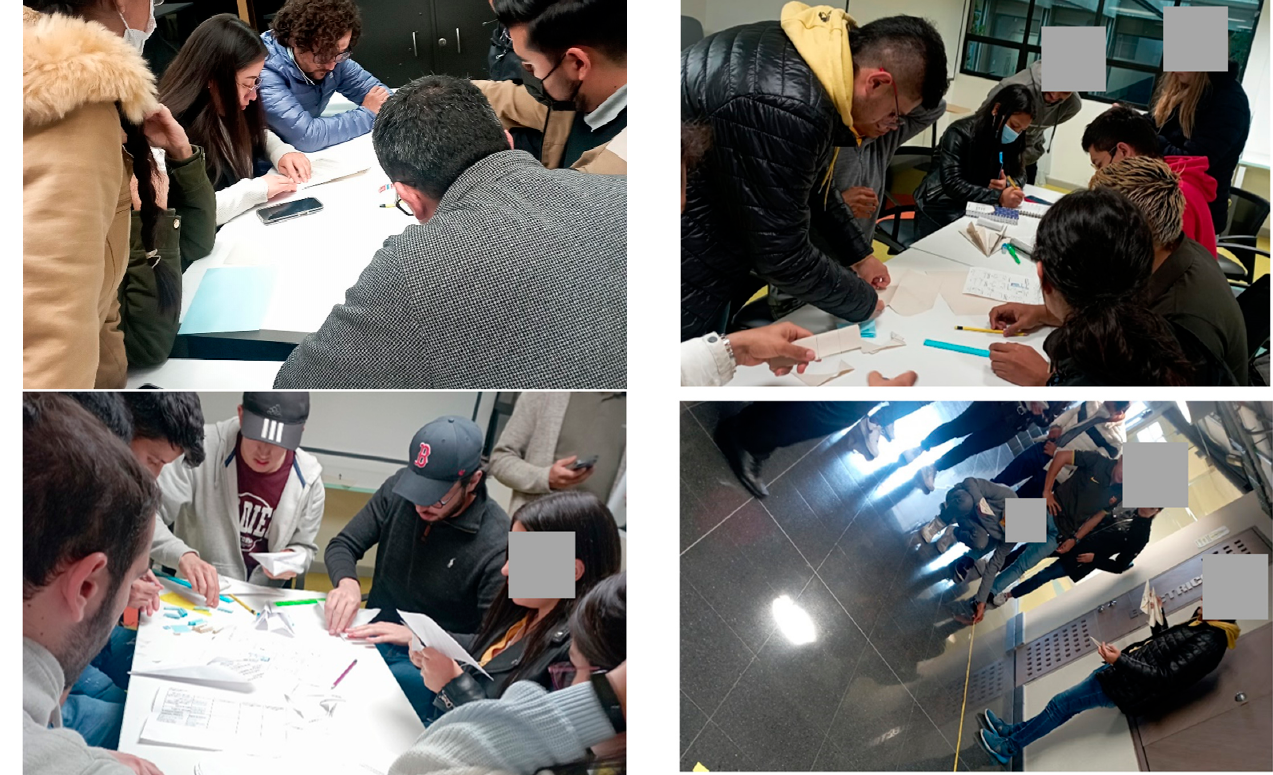
Figure 8. Application of the game in undergraduate and graduate courses.